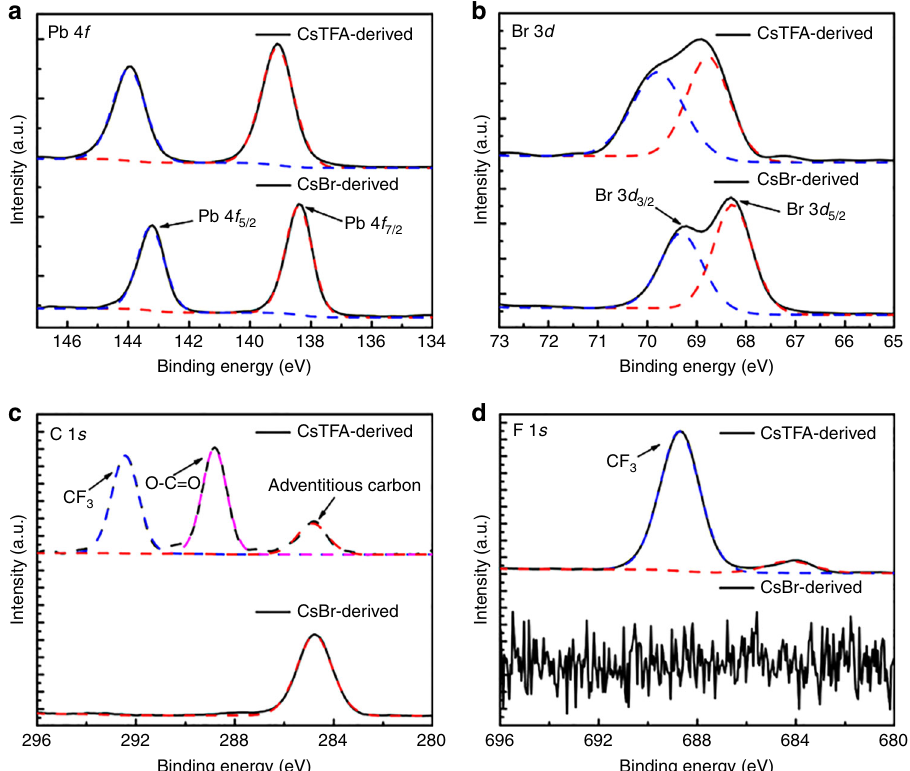
Fig. 3 XPS characterization. High-resolution XPS spectra of the CsBr(1.7)- and CsTFA(1.7)-derived fi lms for a Pb 4 f , b Br 3 d , c C 1 s and d F 1 s elements